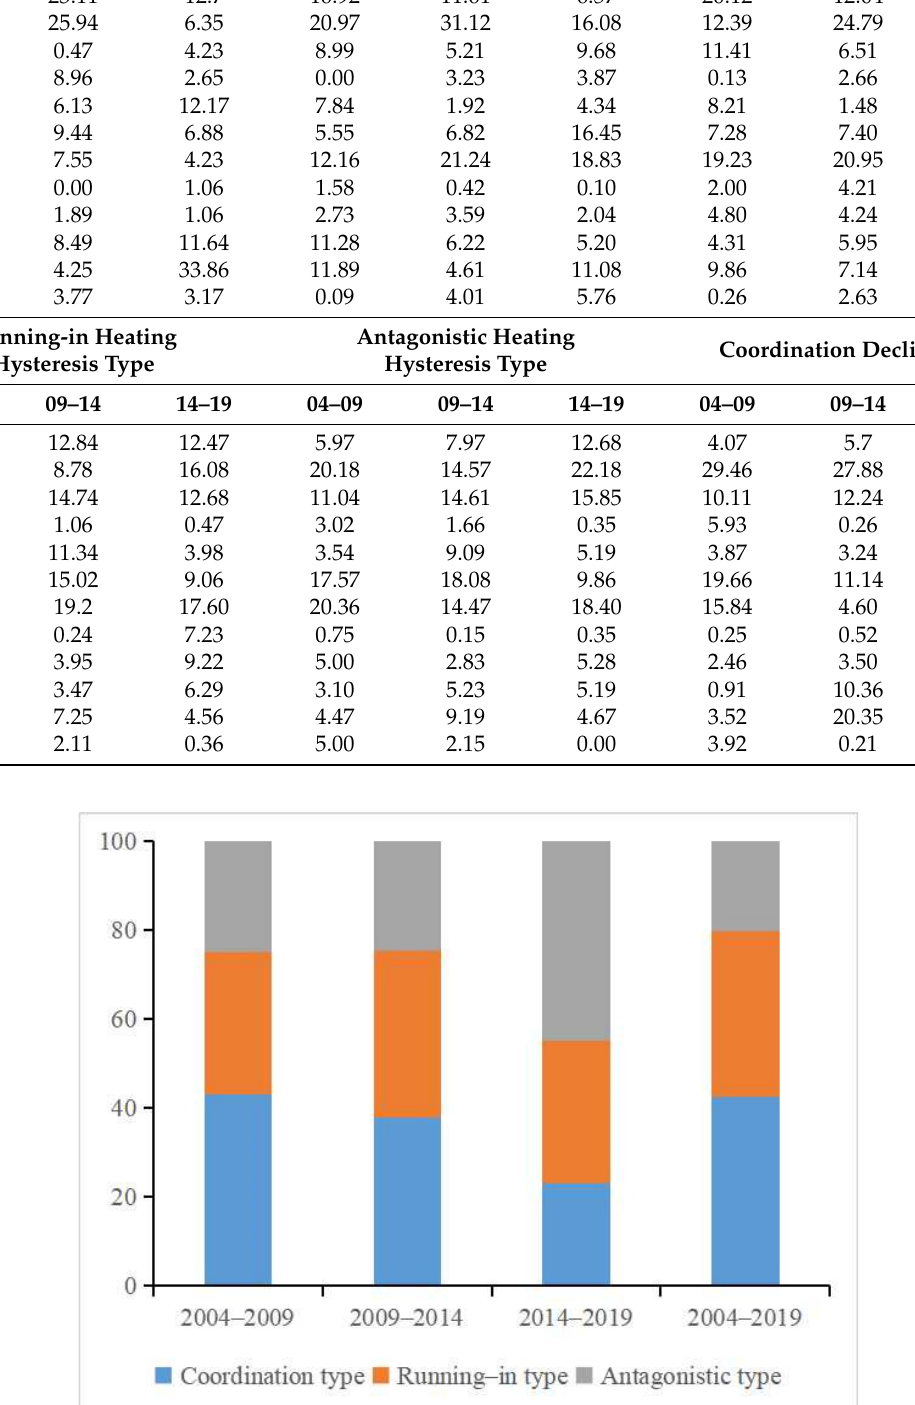
Figure 7. Proportions of the coordination types between NTL and LST within the sixth ring road of Beijing from 2004 to 2019.